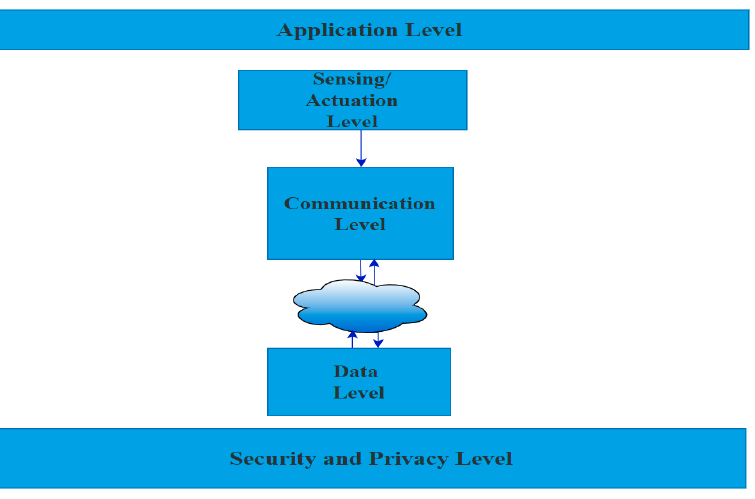
Figure 1. Block diagram plans architecture of smart grid applications.